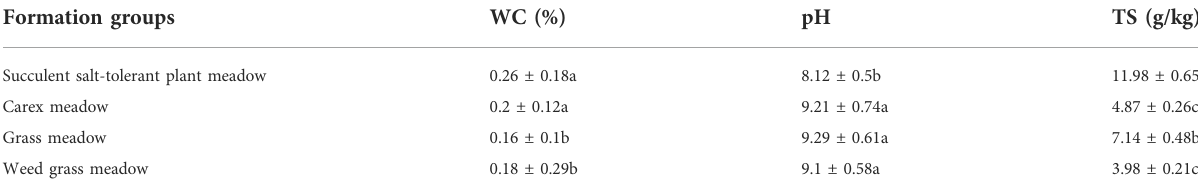
TABLE 3 Water content, pH value and total salt content of salt meadow